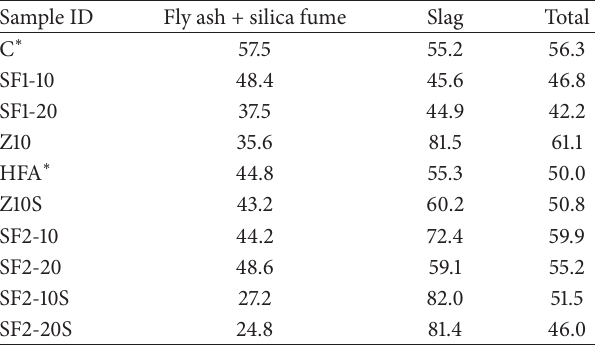
Table 5: Reactivity of raw material calculated by using NMR deconvolution peaks.